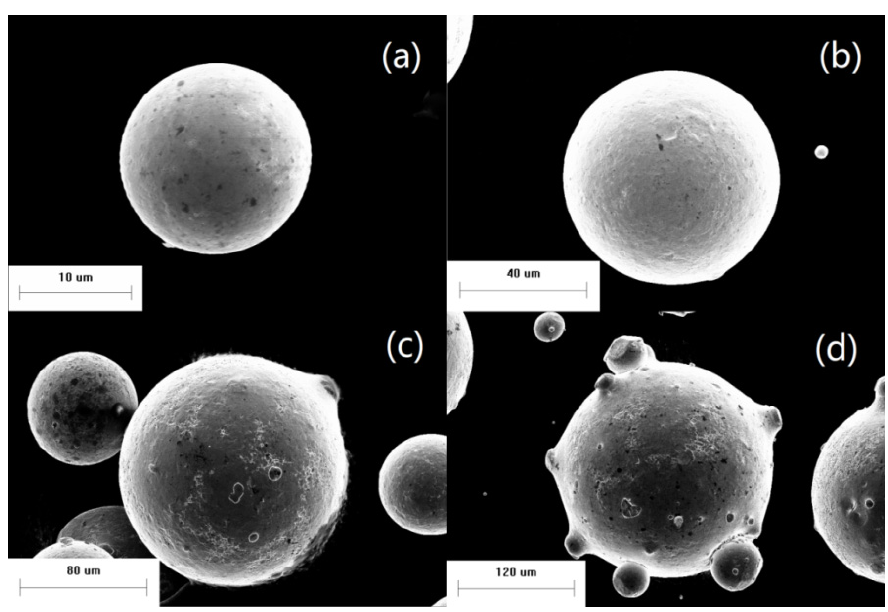
Figure 4. Single-particle morphology of powder: ( a ) d = 17 μ m; ( b ) d = 69 μ m; ( c ) d = 144 μ m; ( d ) d = 229 μ m.